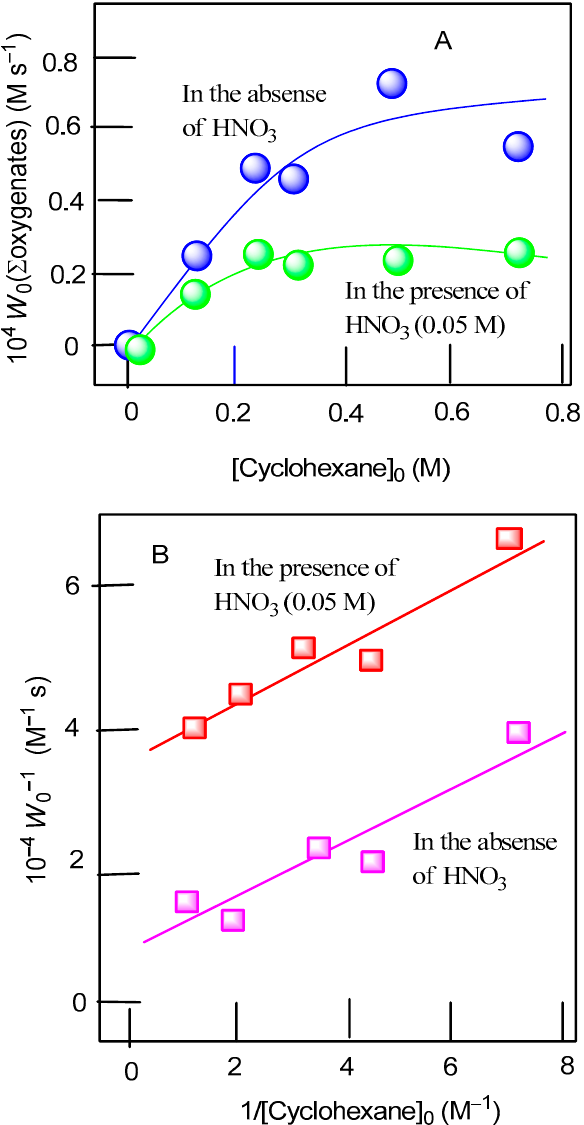
Figure 8. Dependence of the initial rate of oxygenate (sum cyclohexanol + cyclohexanone) formation W 0 for complex 1 on the initial concentration of cyclohexane is shown in graph A . Linearization of the curve from graph A in coordinates W 0 − 1 –1 / [C 6 H 12 ] is presented in graph B . Concentrations of cyclohexanone and cyclohexanol were determined after reduction of the aliquots with solid PPh 3 .